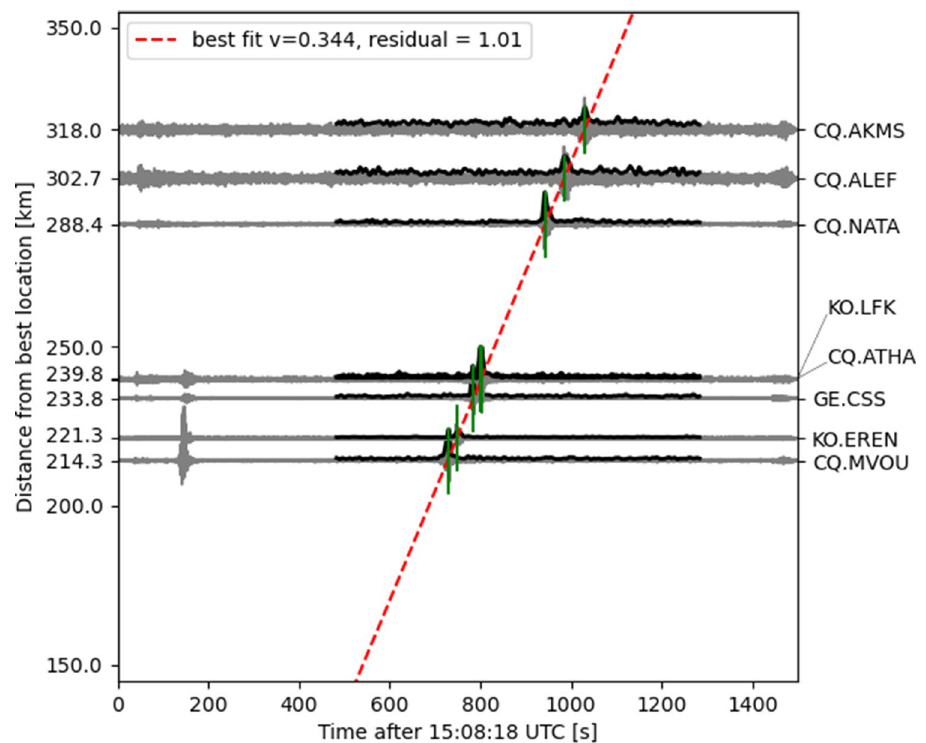
Figure 5. Seismoacoustic localization procedure for seismic stations located on Cyprus. The figure shows continuous waveforms (grey) and their smoothed envelopes (black) in the selected time window. The maxima of the latter were used to define the arrival times (marked as green lines). During grid-search, for each location the least-squares solution is derived, that best fits a straight line through the arrival times. Here, the case of the lowest residuum is shown, which is achieved for an apparent velocity v = 0.344 km/s at the location (33.863 ◦ 35.502 E) (see yellow star in Fig. 1c).